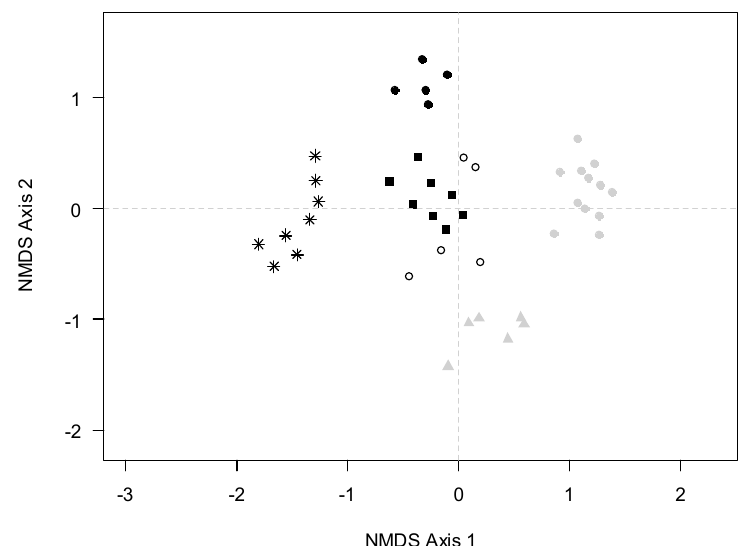
Figure 3. Non-metric multidimensional scaling analysis of species composition for the samples (plots) in the studied montane rain forests. Santiago forest (white circle), Punzara forest (black circle), and Madrigal forest (black square) conform to Group I. Cajanuma forests (gray triangle) represent Group II, Cofradia forests (gray circle) represent Group III, and Achiral forests (star) conform to Group IV. Altitude showed a significant and strong correlation with the NMDS ordination axes, while seasonal temperature and isothermality showed weaker correlations (Table 4). Consistently, altitude, geologic landscape, and lithology factors were relevant predictors of this plant diversity (Table 4). The dissimilarity values indicated high variability of the composition, although there are species that grow indifferently in all groups as Miconia jhanii , Meliosma arenosa , Ilex rupicola , and Meriania tomentosa . We determine 14 families that occur in the four floristic groups. In each group, tree density and relative dominance of the families change along the altitudinal gradient.